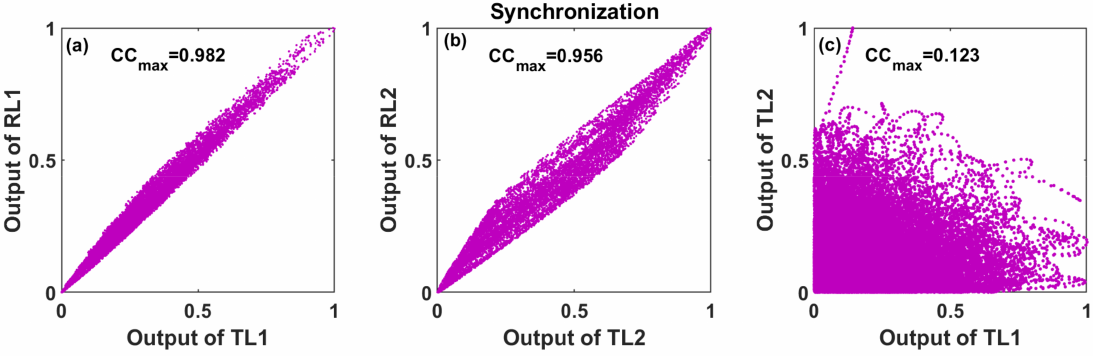
Figure 3. The synchronization plot between ( a ) TL1 and RL1, ( b ) TL2 and RL2, ( c ) TL1 and